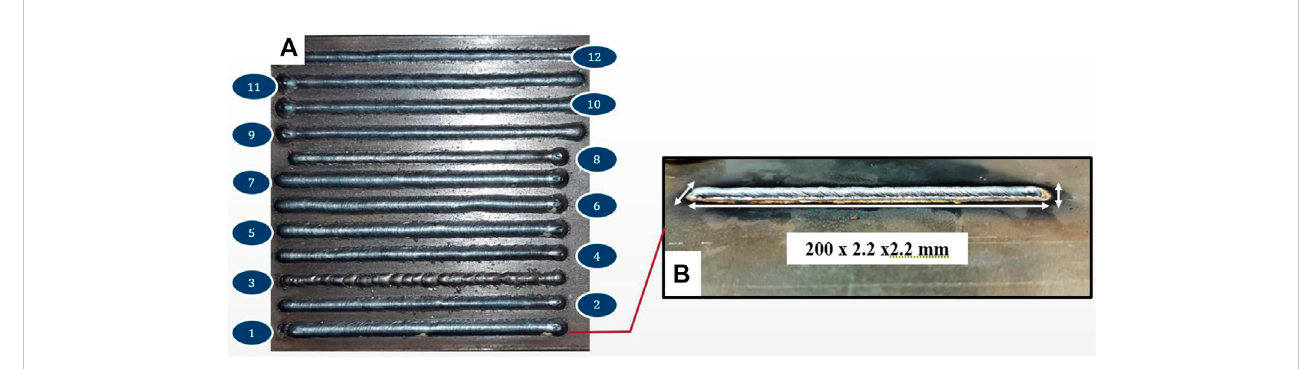
FIGURE 2 (A) Singlebeadparametricprintingforoptimizationofprocessparameterswithbead#1exhibitingthemostdesirablecharacteristics,and (B) anenlarged view of an isolated bead produced using the optimized settings.